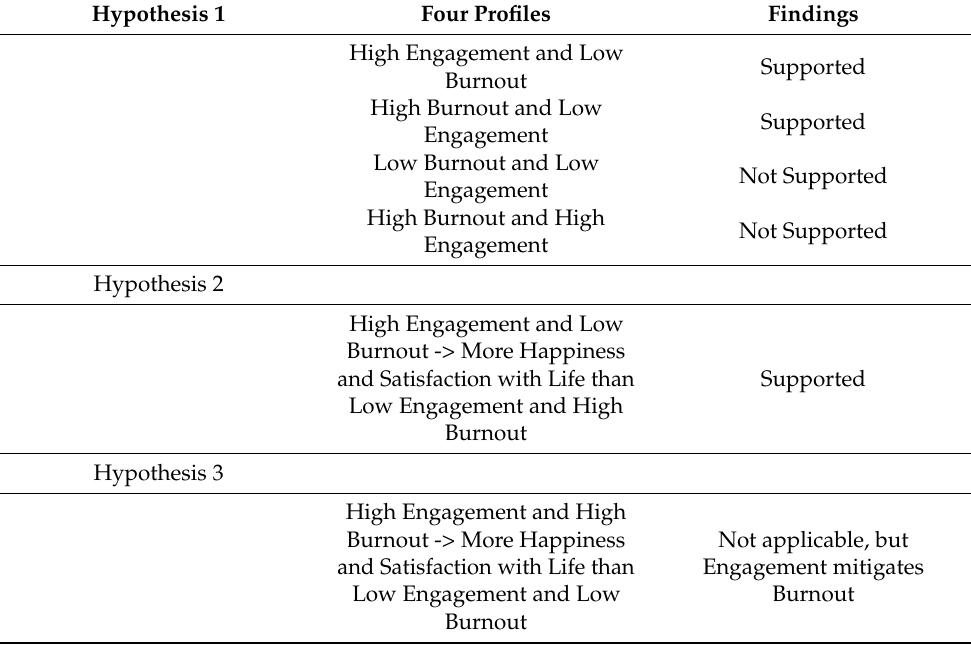
Table 8. Summary of hypotheses and